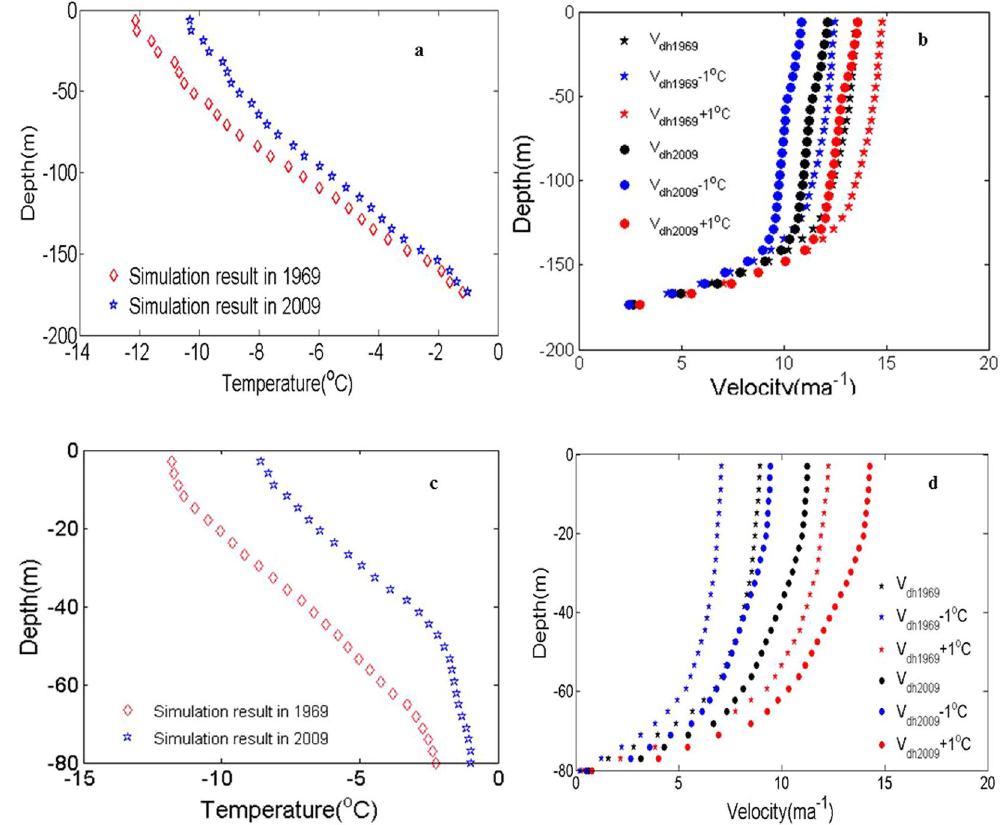
Figure 14. The simulated ice temperature and velocity under different ice thicknesses. ( a ) The simulated ice temperature in 1969 and 2009 under the condition of ice thickness of 200 m and atmospheric temperature; ( b ) the variation in velocity under the condition of ice thickness of 200 m and a rise in atmospheric temperature by 1 °C in 1969 and 2009; ( c ) the simulated ice temperature in 1969 and 2009 under the condition of ice thickness of 80 m and atmospheric temperature; ( d ) the variation in velocity under the condition of ice thickness of 80 m and a rise in atmospheric temperature by 1 °C in 1969 and